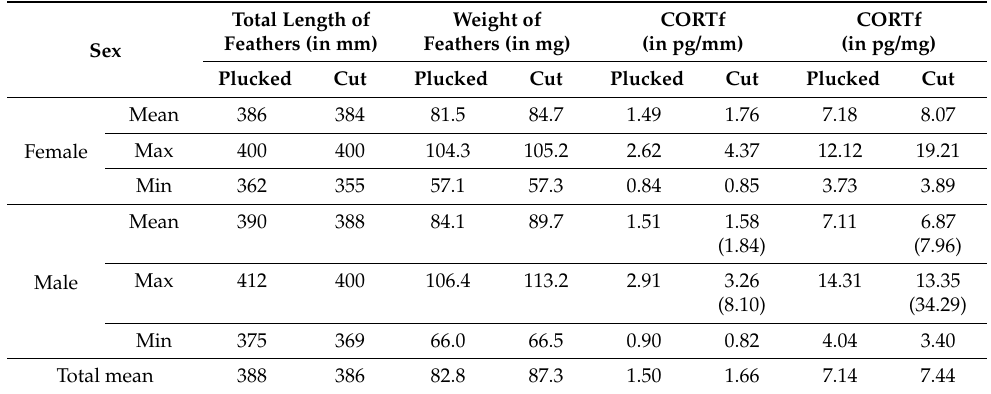
Table 1. Overview of the measured results (total feather length, weight of feathers, and CORTf) of 46 (47) Mallard ( Anas platyrhynchos ) compared between sexes, with 22 females and 24 (25) males, and sampling method (plucked vs. cut); 9 to 10 feathers were used for analysis. The values in brackets indicate the results including the outlier.